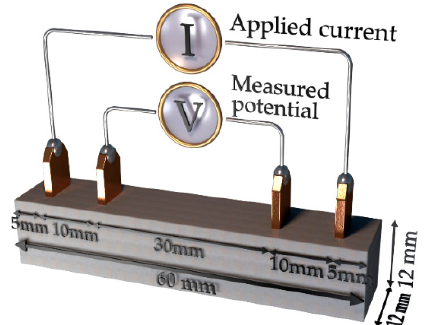
Figure 2. Arrangement of copper electrodes in the mortar sample.